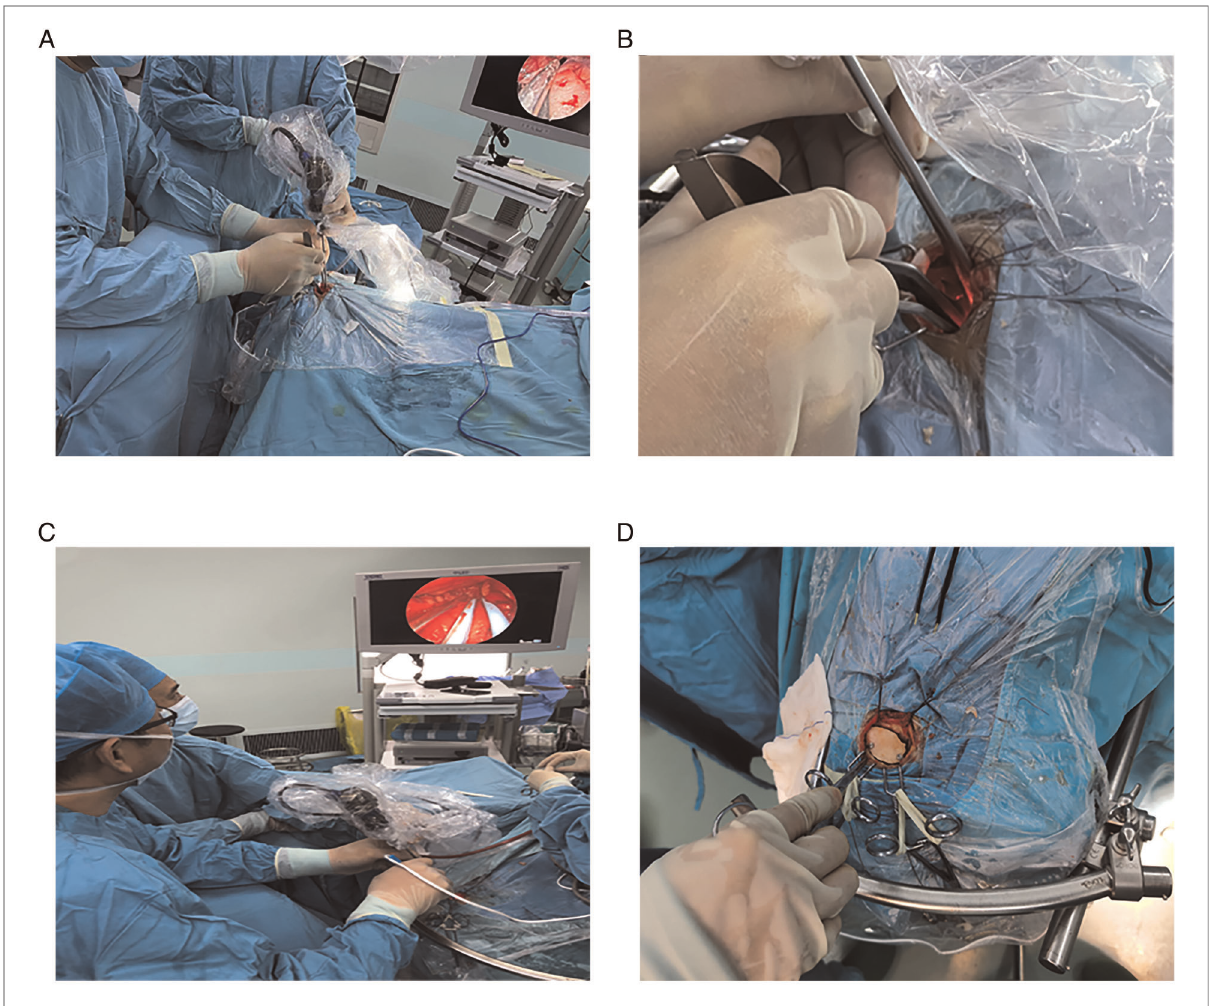
FIGURE 3 Subdural endoscopic operation. ( A – C ) Location of the endoscope, instrument, and operators. ( D ) Resetting of the bone fl